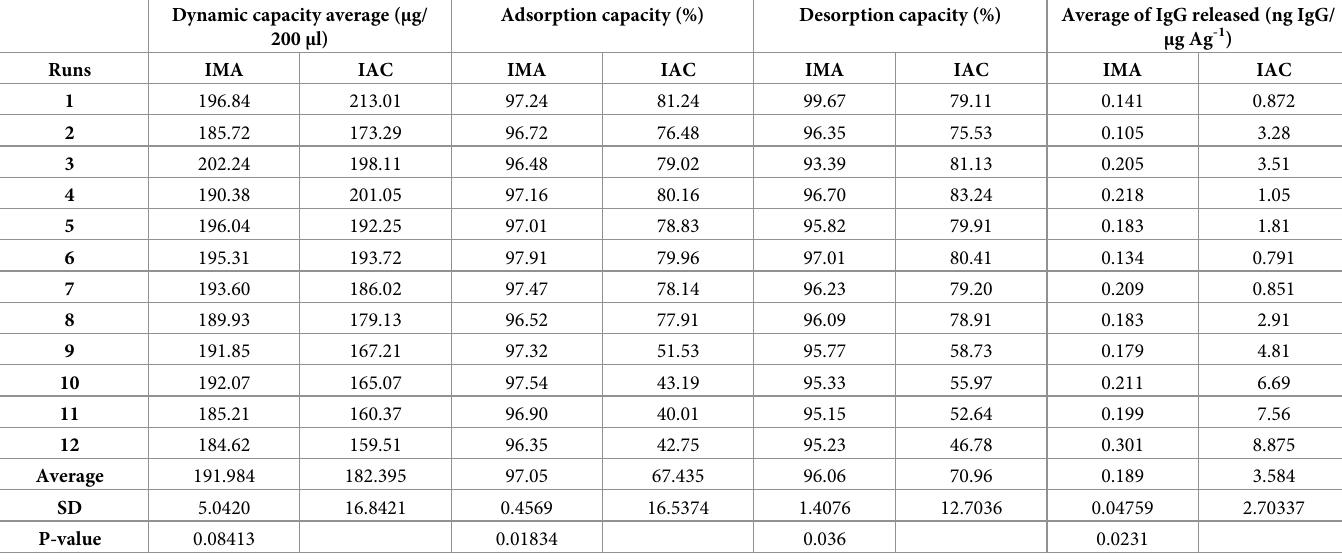
Table 3. Results of the evaluation of the HBsAg immunoaffinity and immunomagnetic separations experiments. Dynamic capacity average ( μ g/ 200 μ